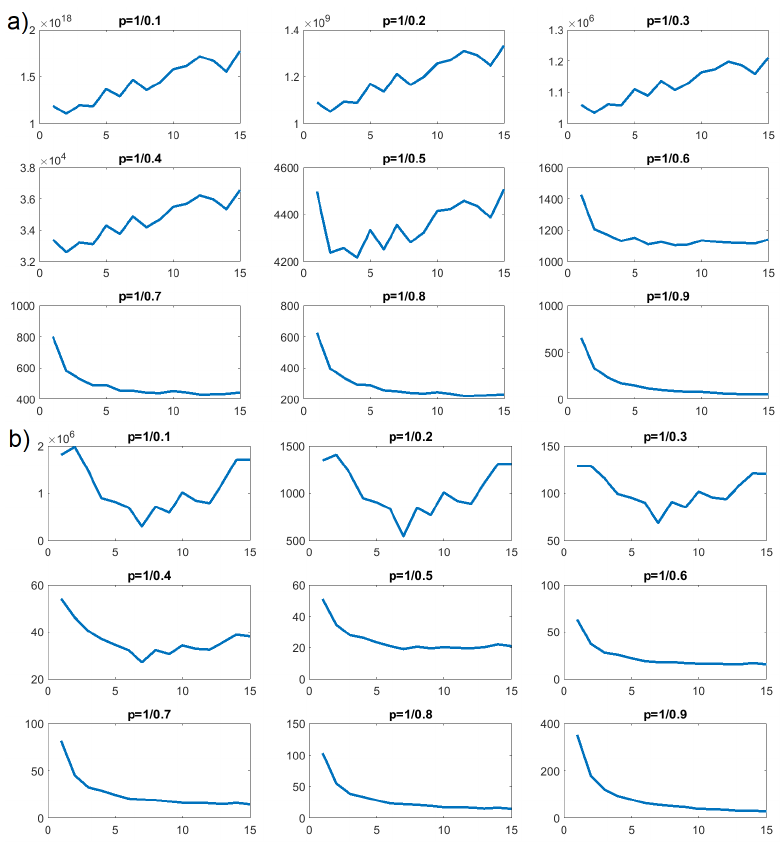
Figure 13. p -variation as a function of n for HBO in concentration c 4 : ( a ) intermolecular; ( b )